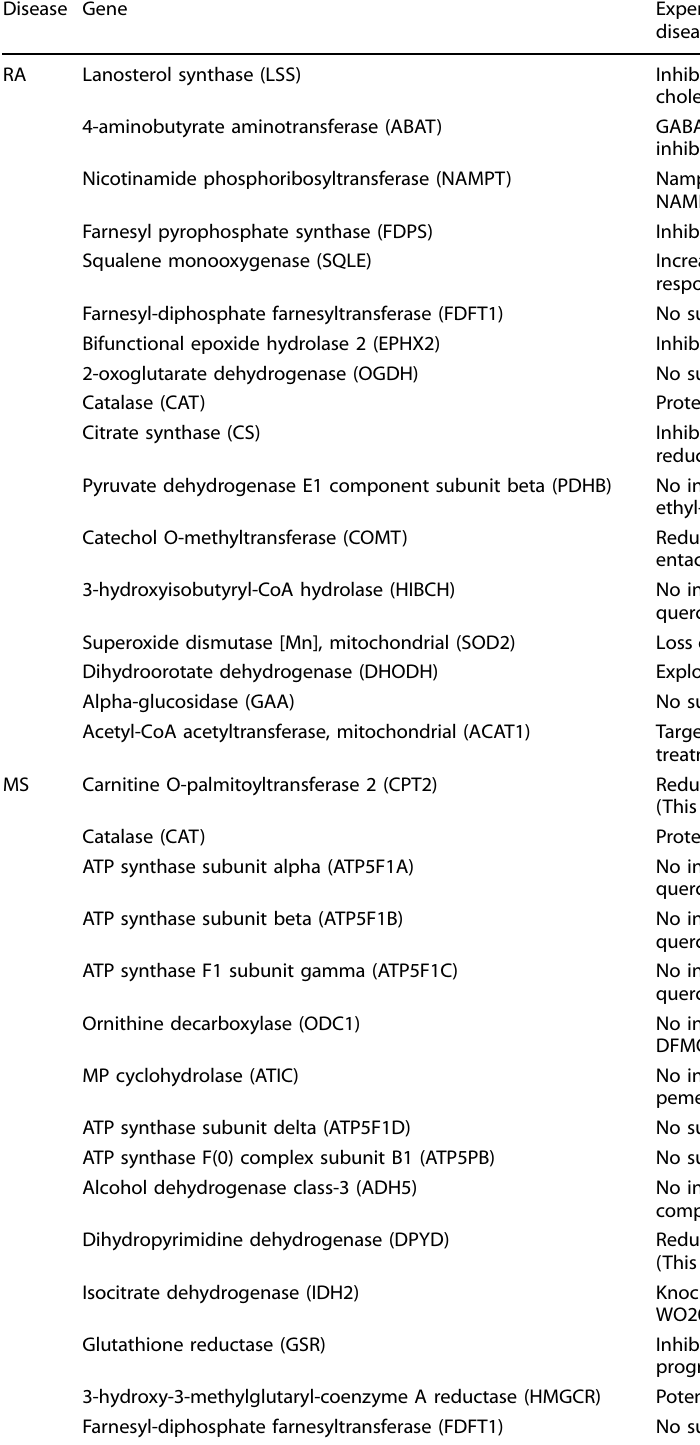
Table 2. Identi fi ed CD4 + T-cell drug targets for autoimmune diseases. Disease